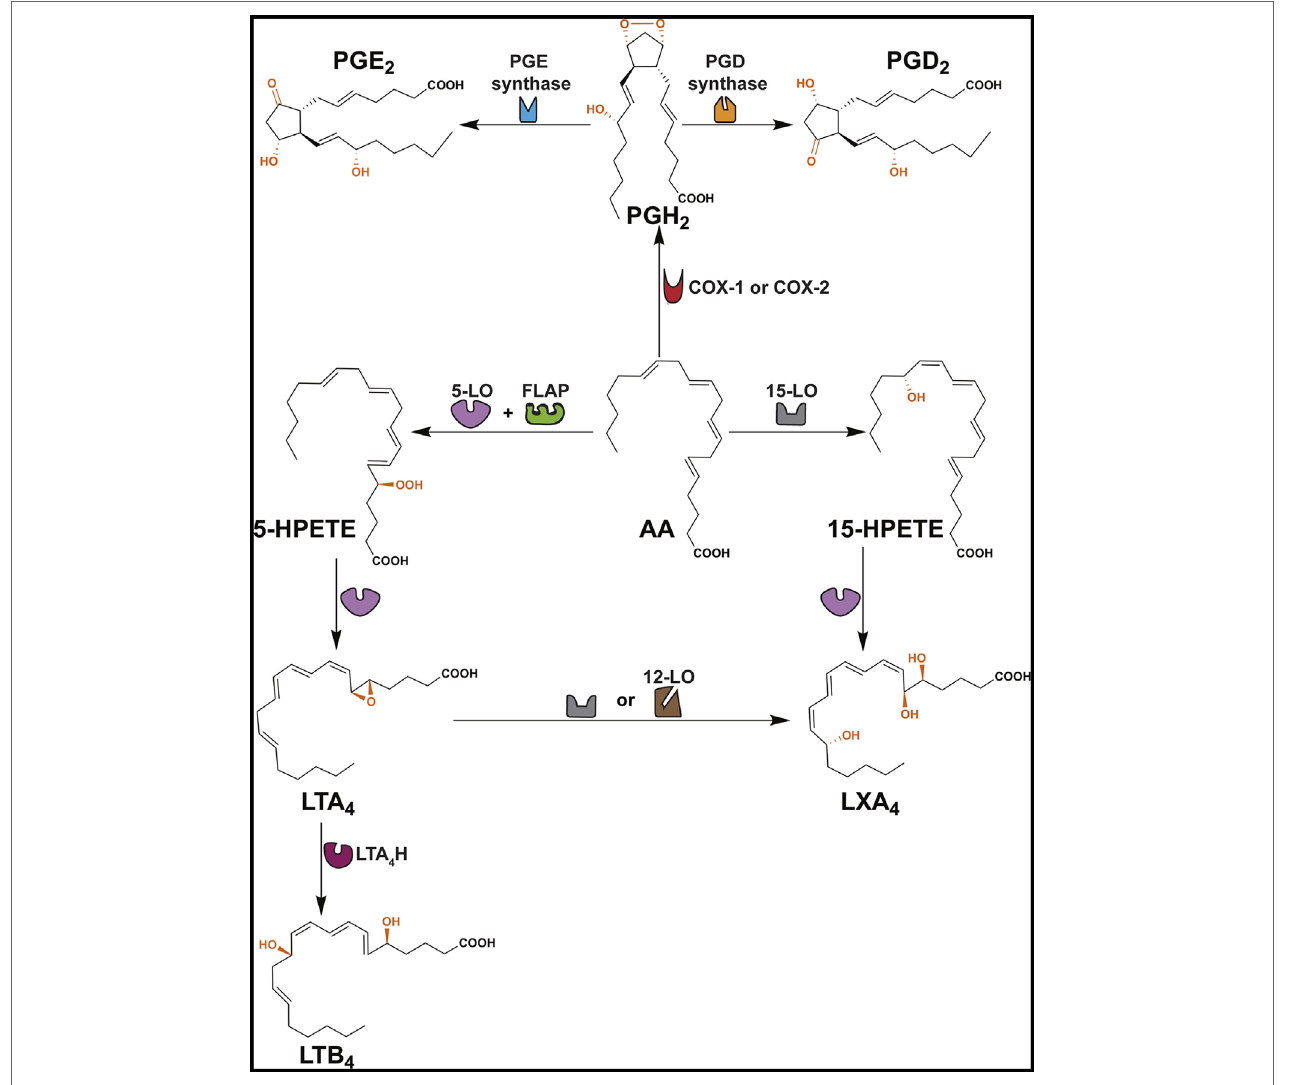
FigURe 1 | Formation of PGD 2 , PGE 2 , LTB 4 and LXA 4 . This scheme shows that arachidonic acid (AA) is converted to several ω 6 PUFA-derived lipid mediators through cyclooxygenase (COX) and lipoxygenase (LO) pathways. COX enzymes (constitutive COX-1 or inducible COX-2) exhibit a COX activity that incorporates two molecules of oxygen into AA to form PGG 2 (not shown) and peroxidase activity that catalyzes a 2-electron reduction of PGG 2 to PGH 2 . PGH 2 is the direct precursor of PGD 2 and PGE 2 . Formation of LTB 4 occurs via the precursors 5-HPETE and LTA 4 . LXA 4 is derived from 15-HPETE and/or LTA 4 . FLAP, 5-lipoxygenase-activating protein; LTA 4 H, leukotriene A 4